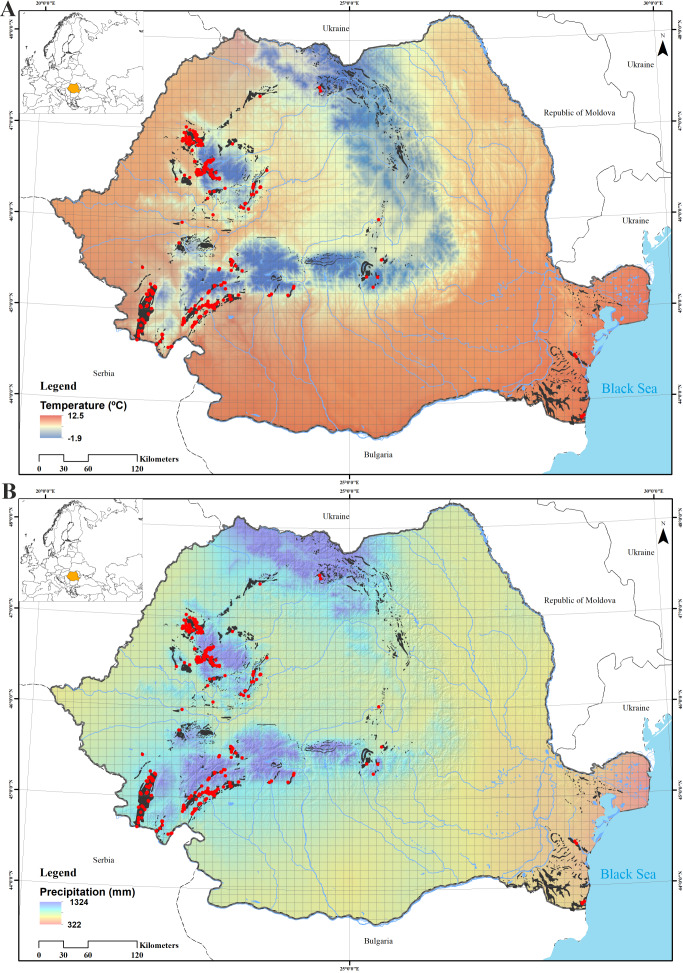
The annual mean temperature (A) and precipitation (B) in Romania, the red dots representing the caves with troglobionts/stygobionts. Climatic data from Fick and Hijmans (2017).